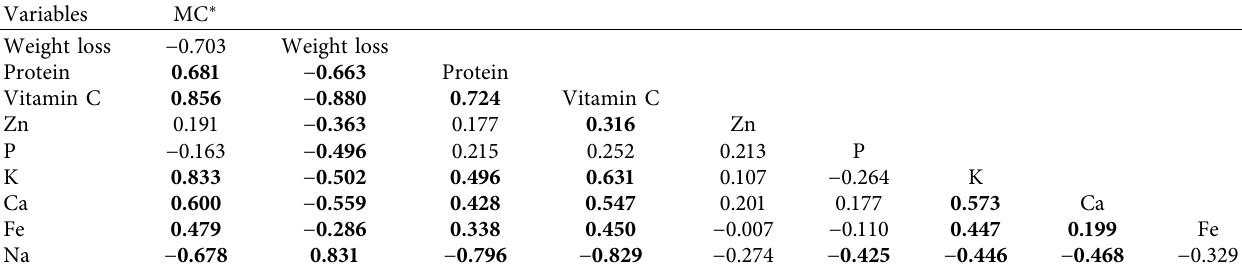
Table 6: Pearson’s correlation matrix between nutritional variables in stored bulb